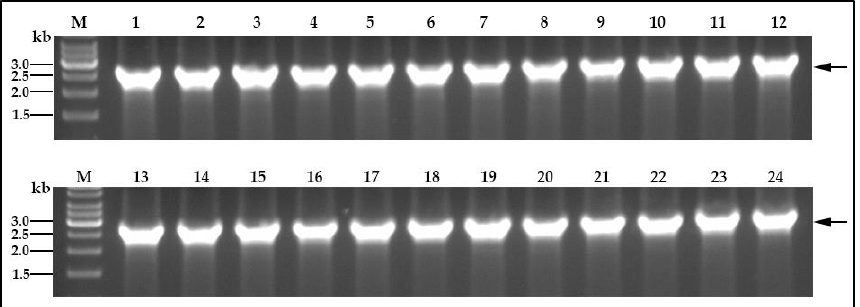
Figure 5. Construction of B. cereus 007 and visualization of GerD-mScarlet-I in dormant spores. ( A